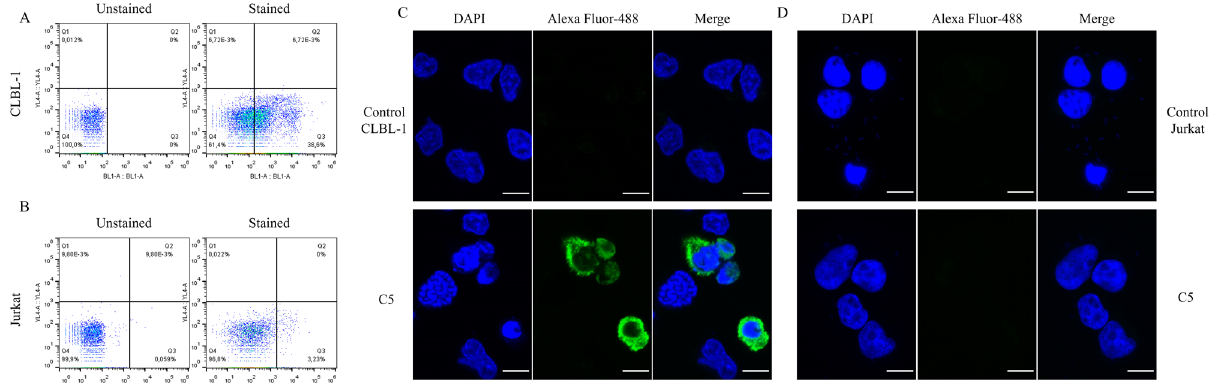
Figure 4. Binding and internalization characterization of C5 VL sdAb. C5 binding and internalization properties against CLBL-1 and Jurkat cells were evaluated by flow cytometry and immunofluorescence. ( A ) For flow cytometry analysis, 1 × 10 6 of CLBL-1 cells were incubated with Live/Dead reagents for 30 min. Then, 3 µM of C5 were incubated with the cells for 90 min at 37 °C. After, cells were washed, fixed with PFA, permeabilized and incubated for 30 min with anti-HA antibody (1/50), washed twice and incubated with anti-rat Alexa Fluor-488 (1/250). C5 has demonstrated to bind to the CLBL-1 cells. ( B ) 1 × 10 6 Jurkat cells were exposed to the same protocol as CLBL-1 cells. By contrast, no binding of C5 was detected with Jurkat cells. ( C ) To confirm the binding of C5 to the CLBL-1 verified by flow cytometry, we evaluated its distribution on the cells by immunofluorescence assay. 1 × 10 6 of CLBL-1 and Jurkat cells were plated on ibidi µ-Slide 8 Well Glass Bottom and incubated with 3 µM of C5 for 90 min. After incubation, cells were washed, fixed, permeabilized, blocked and incubated overnight with rat anti-HA (1/50). Next day, cells were washed and incubated with anti-rat Alexa Fluor-488 (1/500). At the end, DAPI Vectashield was added to the cells. It is possible to observe a high density of C5 labeled with Alexa Fluor-488 in the perinuclear region. ( D ) In contrast, there is no detectable fluorescence in the control image, nor in the Jurkat cells. Representative microphotographs with C5 (green) and DAPI stained- nuclei (blue) are